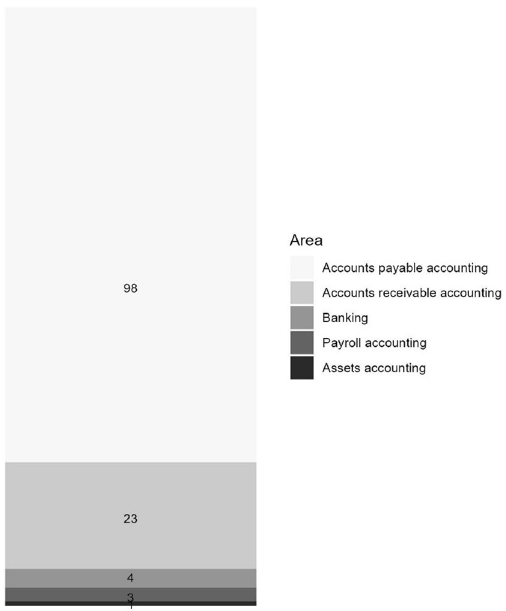
Fig. 8 Areas of activities in financial accounting